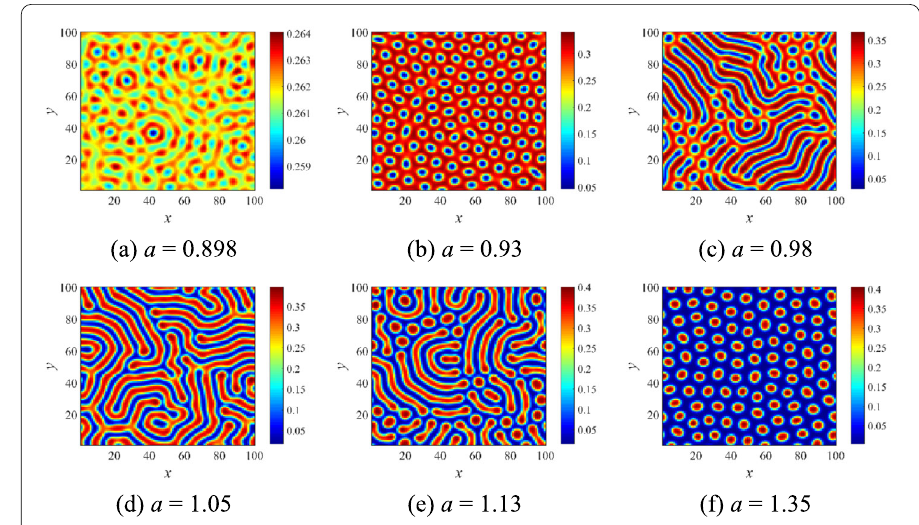
Figure 2 Distribution of different types of patterns in a region diagram of parameters a and b . The meaning of marks are described as follows: eight-pointed stars for homogeneous stationary state, five-pointed stars for approximately homogeneous patterns, inverted triangles for cold spot patterns, triangles for cold spot-stripe patterns, diamonds for stripe patterns, dots for hot spot-stripe patterns, and squares for hot spot patterns. e 1 = 0.3,